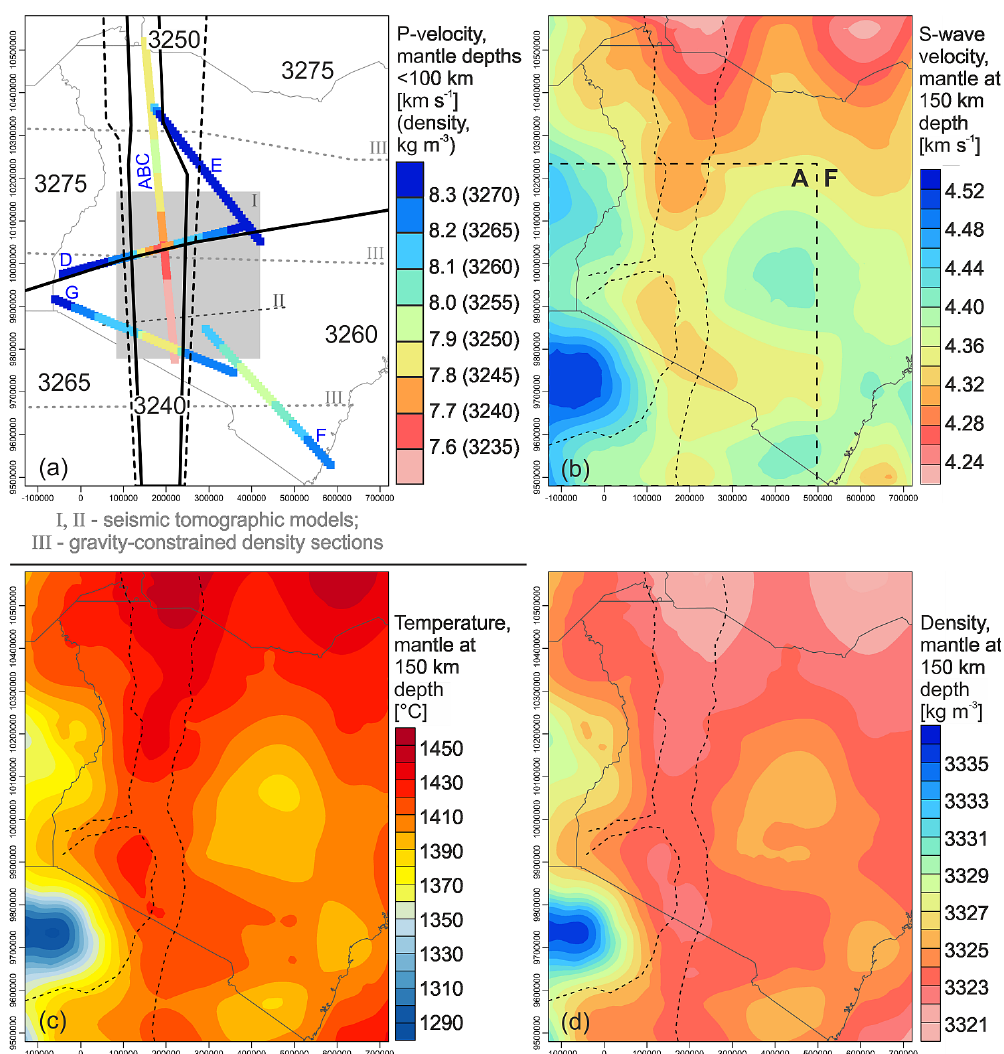
Figure 5. Analysis of mantle seismic velocities. (a) Six density domains (separated by black lines; numbers in kgm − 3 ) have been derived from P wave velocities for depths between the Moho and 100km; the low-density domains underneath the rift are slightly narrower at the Moho (solid lines) than at 100km depth (dashed lines). KRISP refraction seismic profiles A–G shown with vertically averaged mantle velocity and density (converted according to Eq. 2); I (grey square) – tomographic P wave velocity model of Achauer and Masson (2002); II – tomographic model of Slack et al. (1994); III – gravity-constrained density profiles of Simiyu and Keller (1997). (b) Combined S wave velocity datasets of “A” – Adams et al. (2012) and “F” – Fishwick (2010; separated by the dashed line) at a depth of 150km. (c) Temperature at 150km depth as derived from S wave velocity data according to the approach of Priestley and McKenzie (2006). (d) Density at 150km depth derived from temperature according to Eq. (C1; for details see main